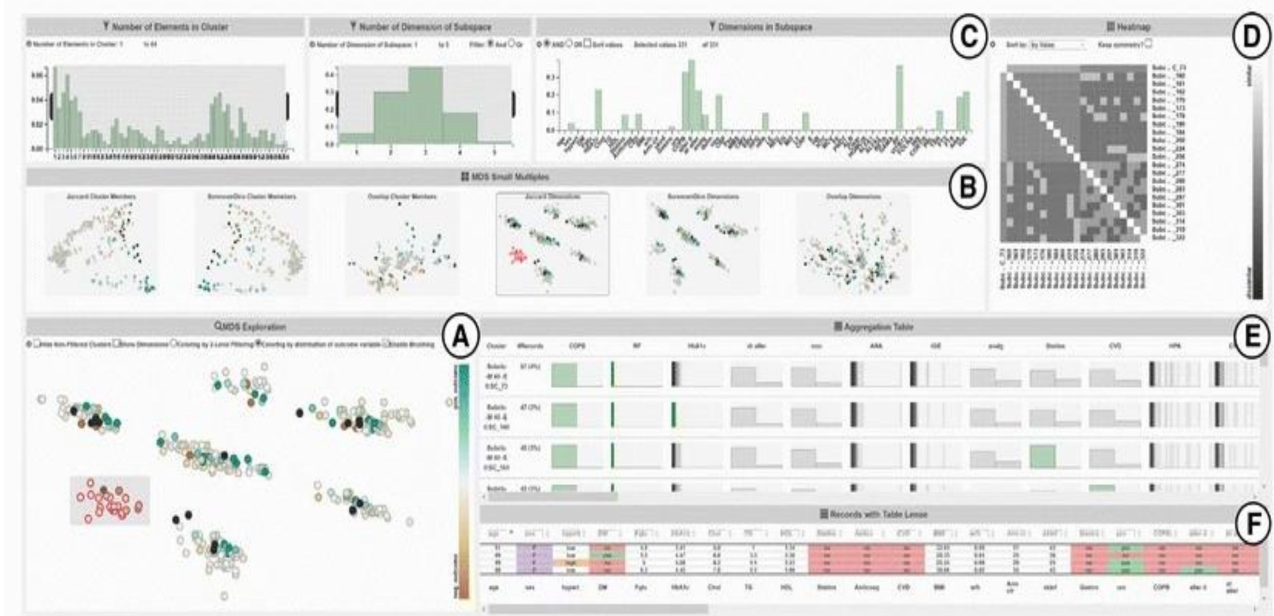
Figure 6. A screenshot of SubVIS [45] including ( A ) MDS projection plot, ( B ) MDS small multiples, ( C ) barcharts showing the distribution properties of the subspaces, ( D ) heatmap, ( E ) aggregation table, and ( F ) table lens. Source: image used under CC-BY License.